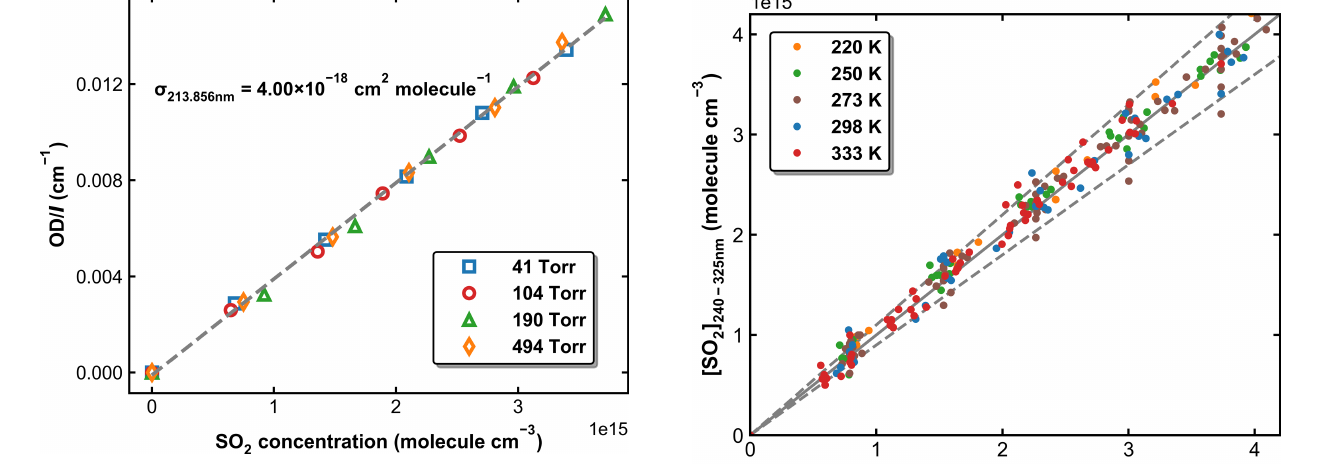
Figure 2. Normalized optical density in the 213.86nm absorption cell as a function of SO 2 concentration measured using the multi- pass absorption cell. The experiments were performed at 298K and pressures of 41, 104, 190, and 494Torr. The dashed grey line is a linear regression, for which the slope is the effective cross-section of SO 2 at 213.86nm.